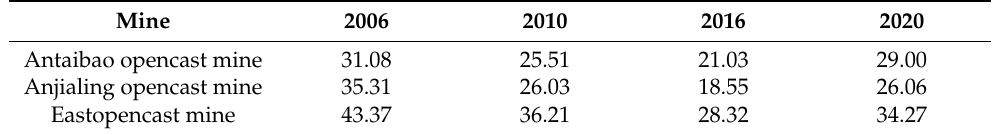
Table 2. NPP change trend table of three opencast mines from